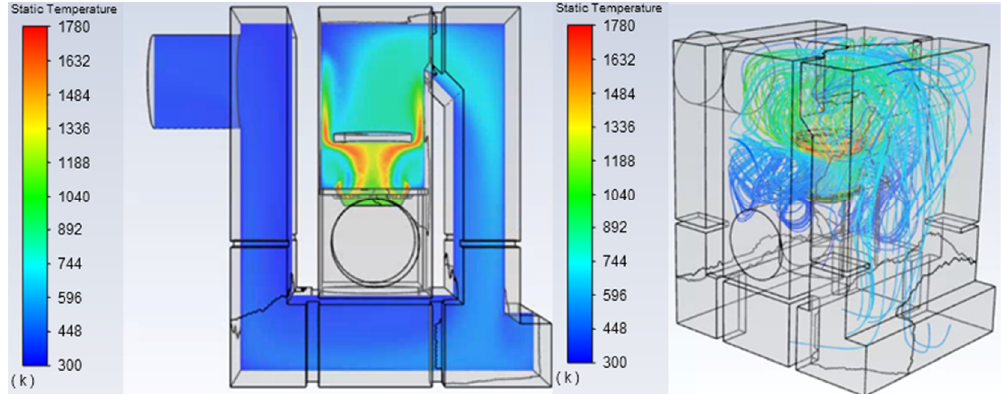
Figure 10. Tracks of gas particles escaping from the burner - time scale (s).